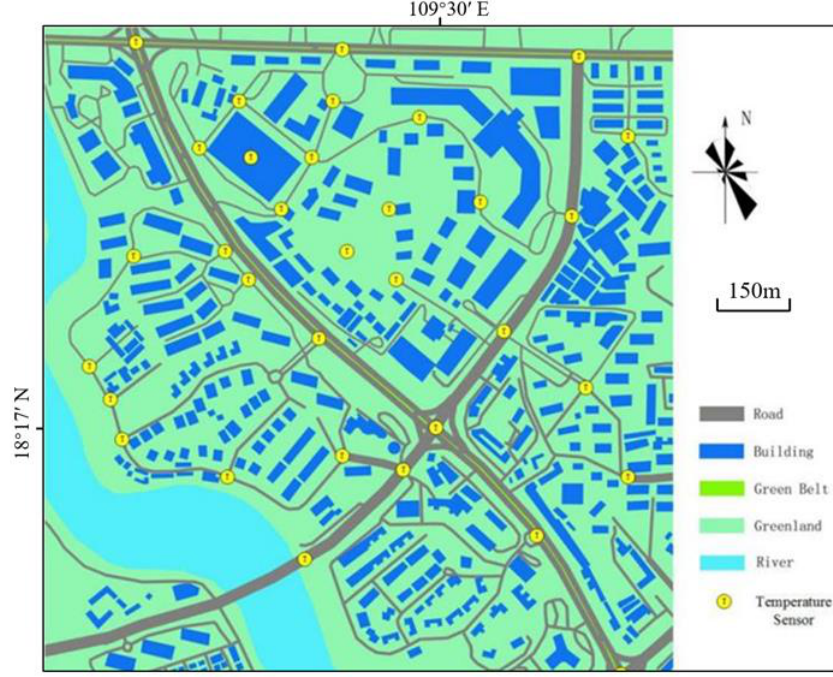
Figure 2. Air temperature and humidity measuring points in the urban study area.